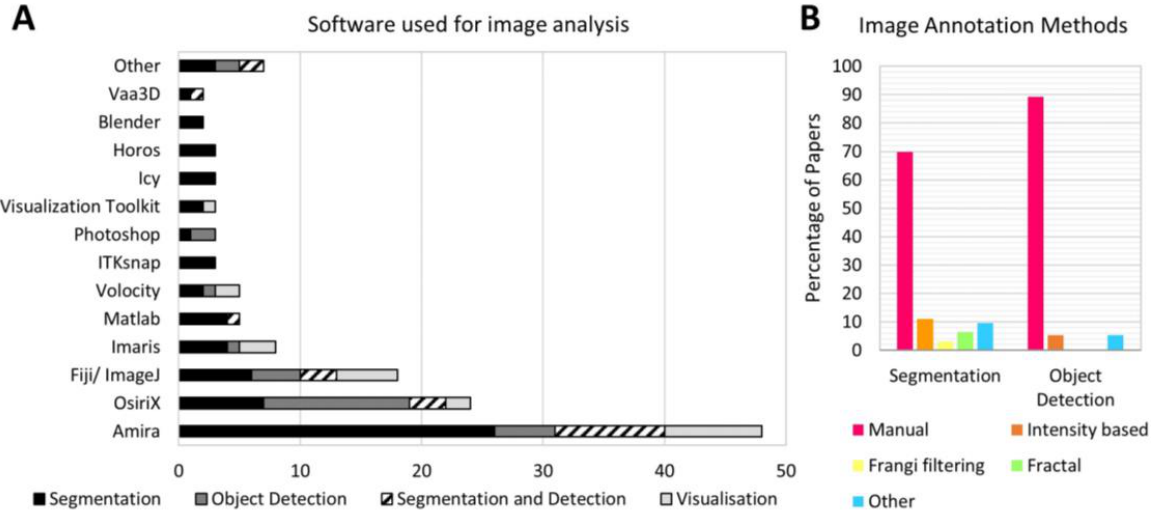
Figure 5. ( A ) Software used for image analysis varied depending on the type of image annotation being performed. Amira was the most popular software for segmentation while OsiriX was more popular for object detection. ImageJ/Fiji was the most commonly used open-source software. ( B )